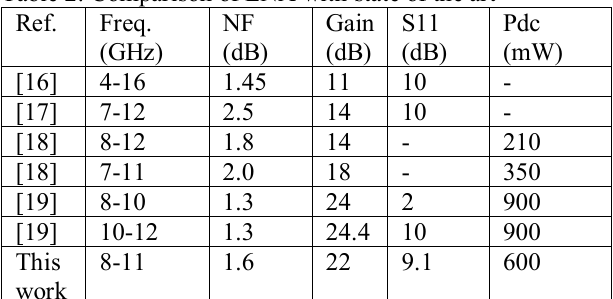
Table 2: Comparison of LNA with state of the art Ref.